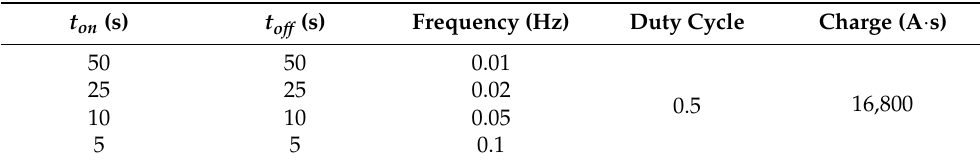
Table 2. Pulse parameters considered for the investigation of the effect of pulse frequency functions on the ED system.